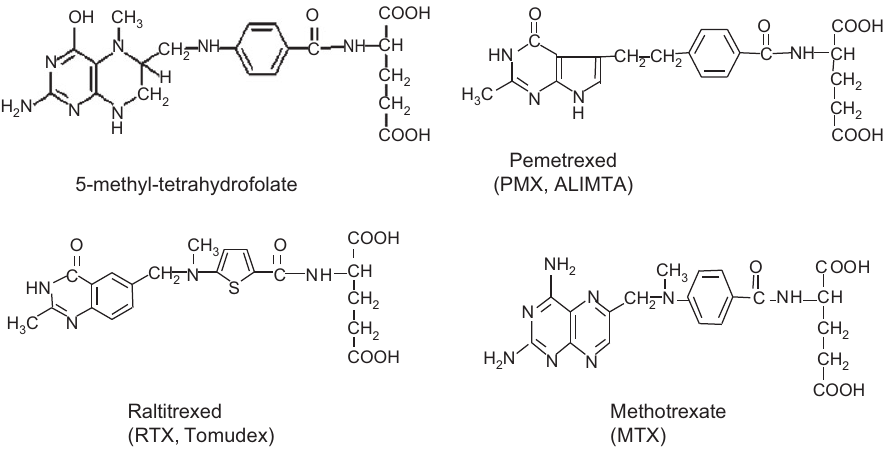
Figure 2 Structural